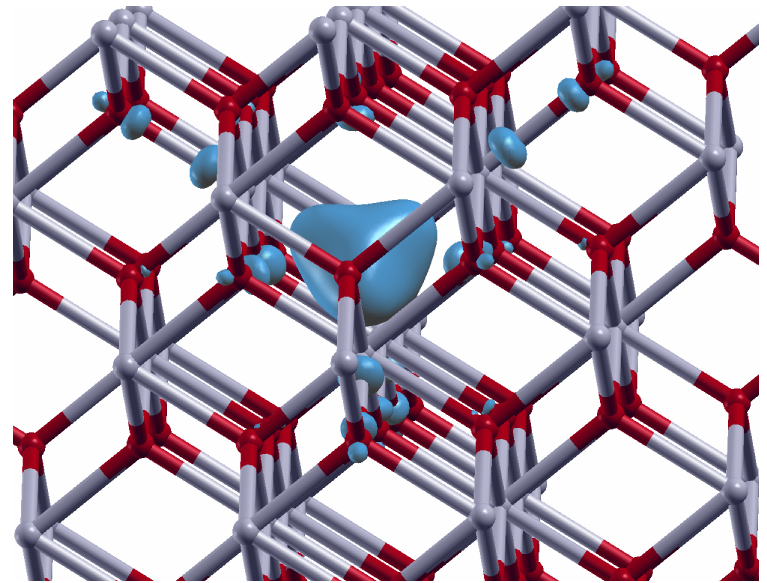
Figure 3. Localization of the excess electrons upon formation of an oxygen vacancy. Zr atoms are shown in grey, oxygen atoms in red. The isosurface of the excess electron density is shown in light blue and is localized mainly around the oxygen vacancy in the middle of the graph.